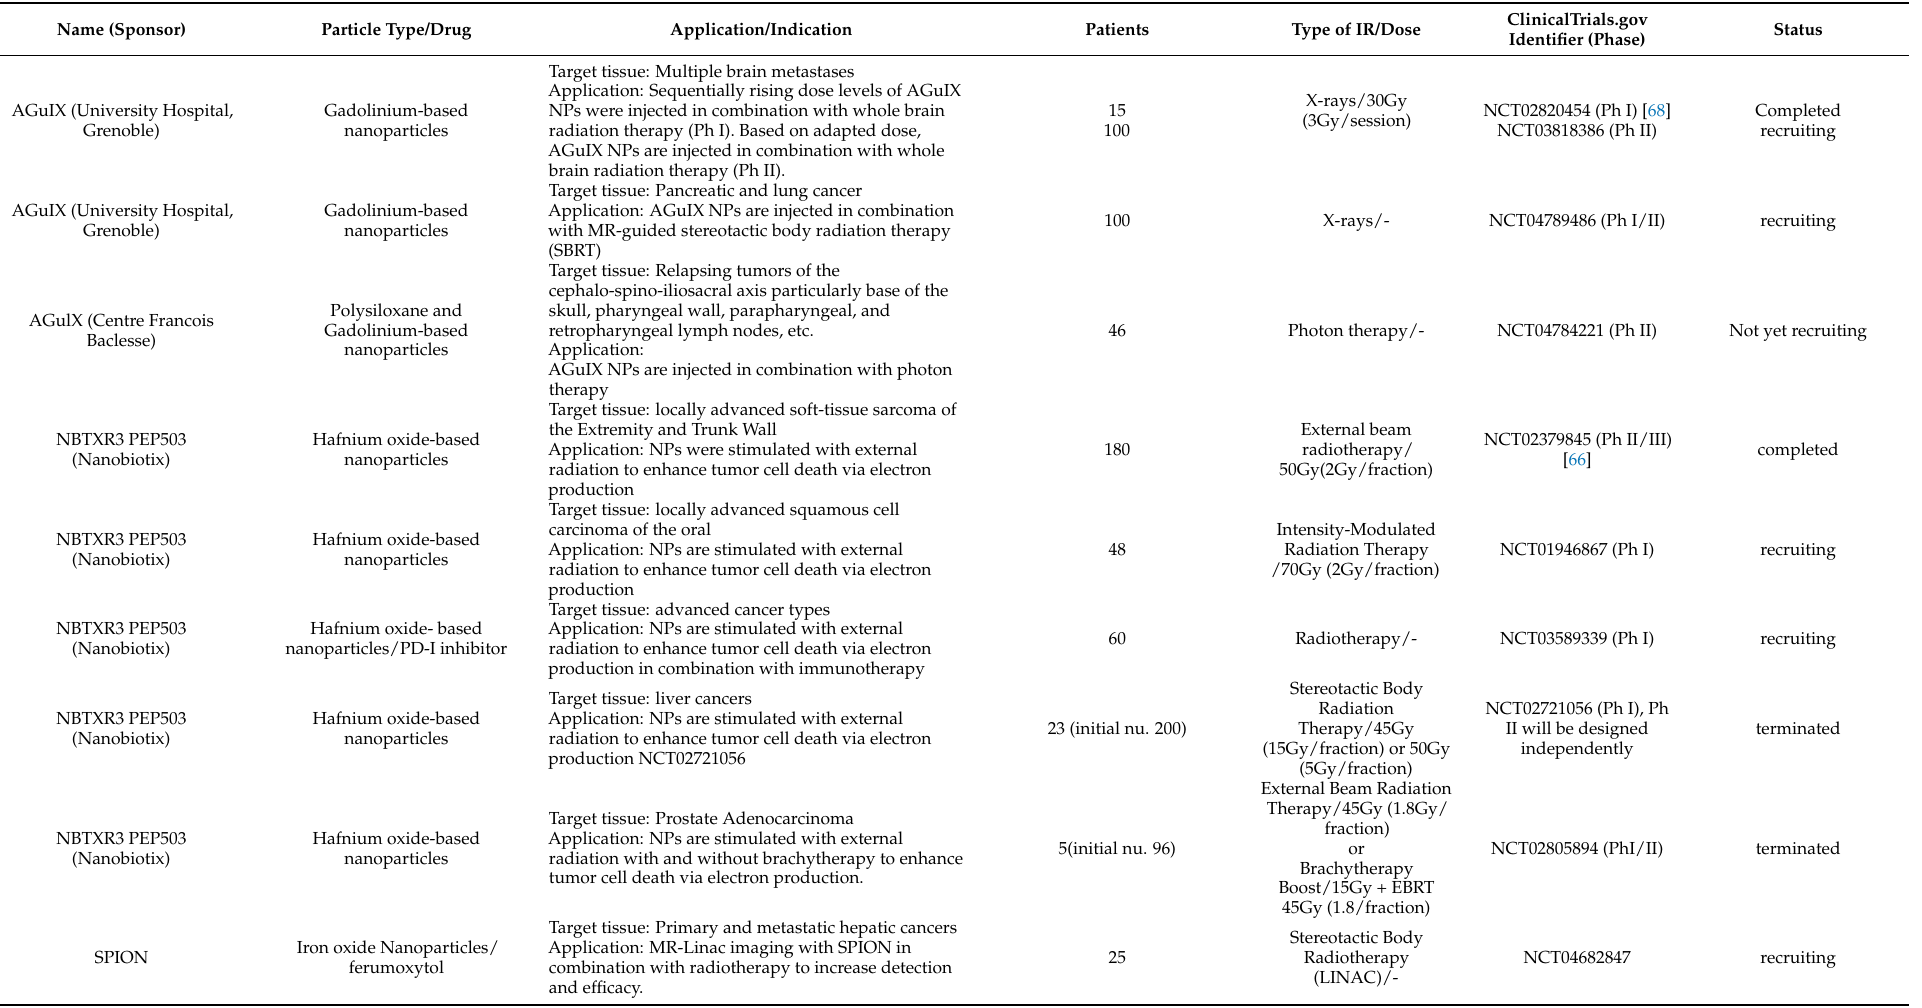
Table 1. Combined nanoparticle-radiation therapies in cancer patients. Table includes currently undergoing or completed clinical trials (not yet recruiting, recruiting, active, completed). Name